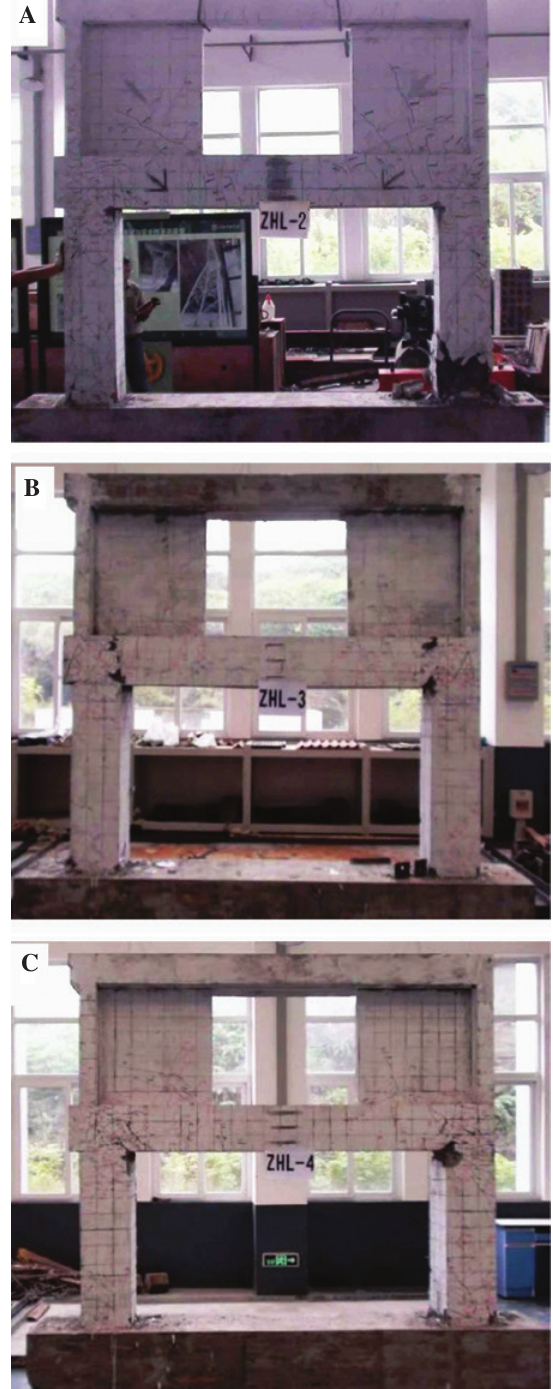
Figure 5: Specimens after failure: (A) the specimen of ZHL-2 after destruction; (B) the specimen of ZHL-3 after destruction; (C) the specimen of ZHL-4 after